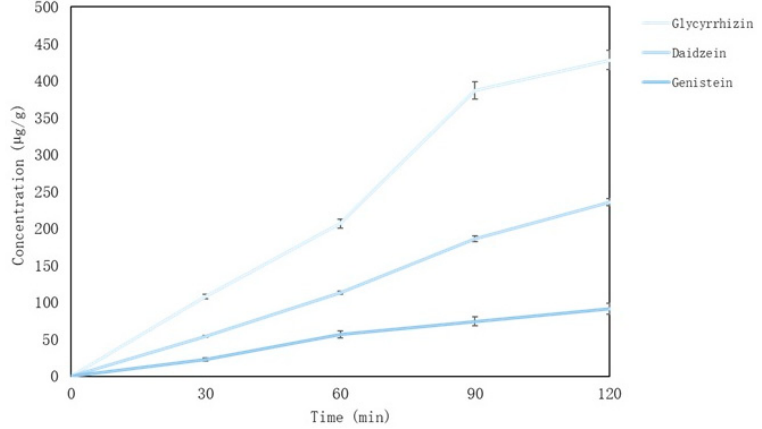
Figure 3. Main compounds (glycyrrhizin, daidzein and genistein) released in vitro from red clover and liquorice microcapsules.